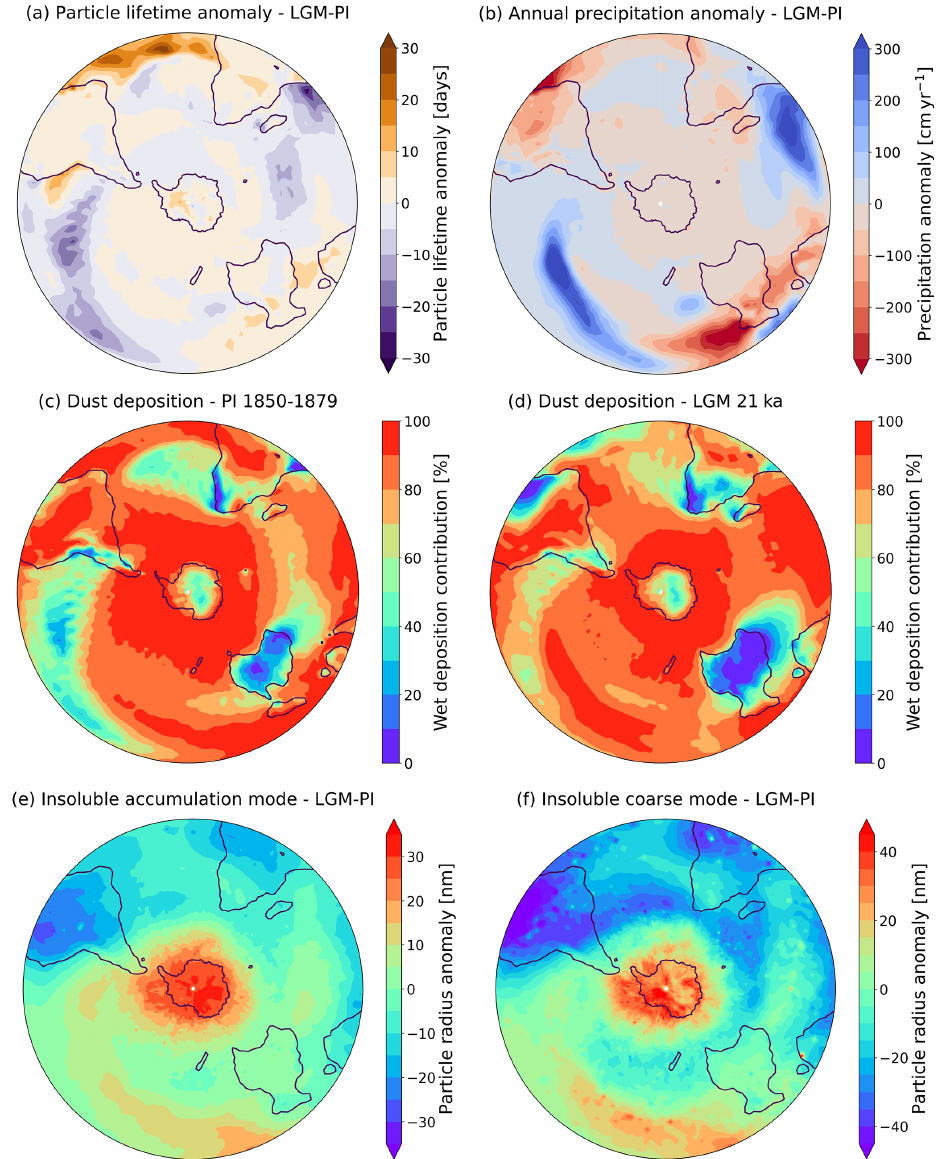
Figure 5. Particle lifetime anomalies (LGM-PI) (in d) (a) , annual precipitation anomalies (in cmyr − 1 ) (b) , and the contribution of wet deposition to the total deposition (in percent) for both the PI (c) and LGM (d) in the Southern Hemisphere. Additionally, particle radius anomalies (in nm) are shown for the insoluble accumulation (e) and insoluble coarse mode (f) .